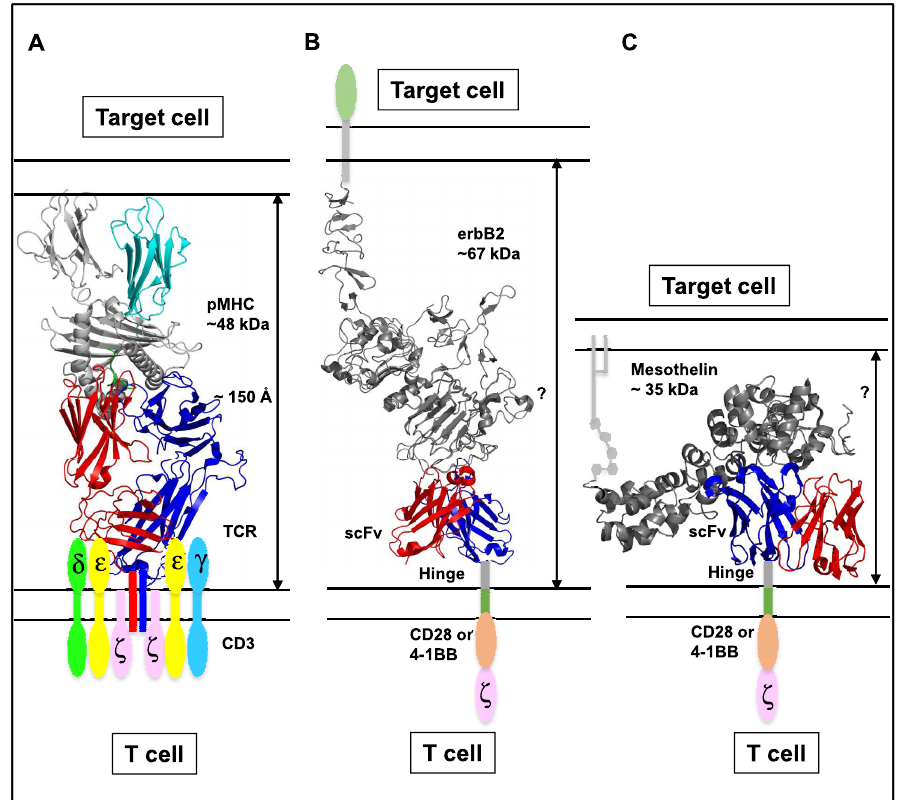
Figure 1. Dimensions of the interaction interfaces involving conventional αβ T-cell receptor (TCR) T cells and chimeric antigen receptor (CAR) T cells. ( A ) TCRs on the surface of T cells interact with peptide-major histocompatibility complex (pMHC) complexes on the surface of target cells (antigen-presenting cells). This conserved interaction spans approximately 150 Å of inter-membrane space between the two cell types. TCRs assemble in the membrane of T cells with subunits of CD3 molecules ( δ , ε , γ , and ζ ) and CD4 or CD8 (not shown). Proximal, intracellular molecules initiate phosphorylation of CD3 subunits and subsequent signaling pathways. Structure of the Mel5 TCR in complex with MART-1 peptide bound to HLA-A2 is shown (PDB: 3HG1) 116 . ( B , C ) CARs typically contain single-chain variable fragment (scFv) domains (V and V ) of an antibody, linked to a hinge or spacer domain, transmembrane domain, and intracellular signaling domains H L (for example, co-stimulatory domains CD28 or 4-1BB and CD3 ζ ). CAR interacts with its antigen present on the target cell surface. Owing to potential differences in the size of the antigen and location of the epitope, the interaction interface of CAR-target antigen can be variable. In ( B ), a representation of a CAR-target antigen interaction interface is shown by aligning the structures of an extracellular domain of the CAR target, ErbB2, in complex with the scFv of an anti-ErbB2 antibody, chA21 (PDB: 3H3B) 63 , with the complete extracellular domain of ErbB2 (PDB: 1N8Z) 64 . To illustrate the range of possible CAR interactions, in ( C ) a representation of another CAR-target antigen interaction